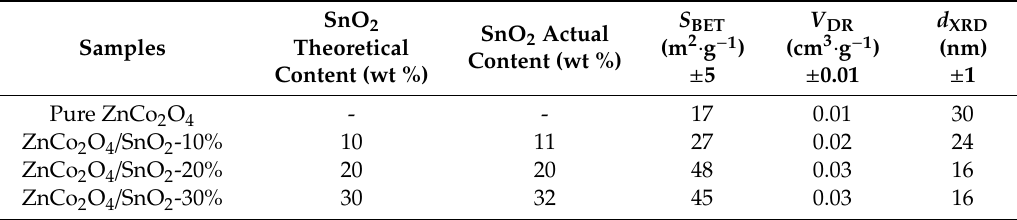
Table 1. Sample composition and textural properties.